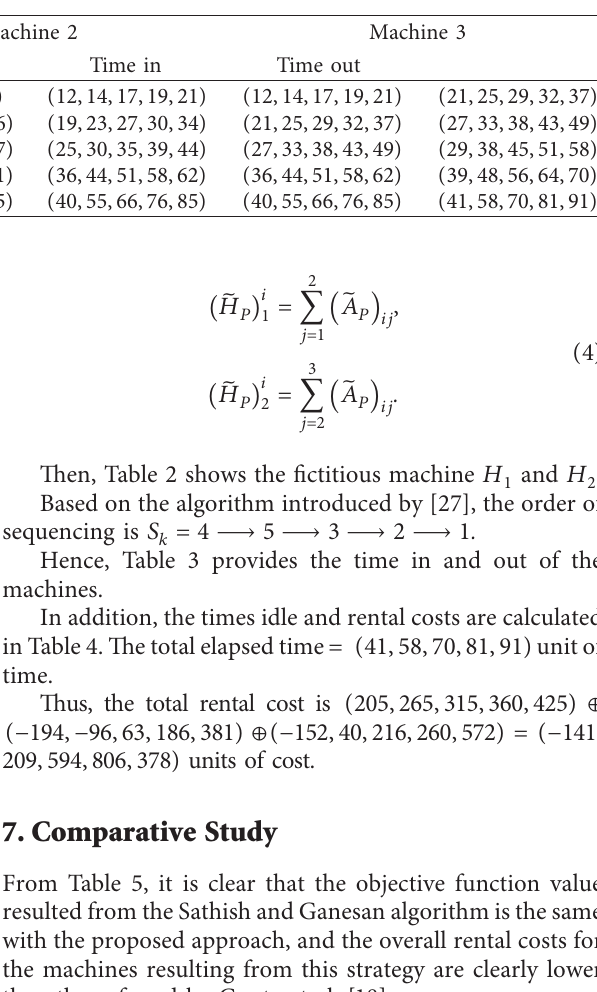
Table 2: Pentagonal fuzzy processing times for fictions machines H